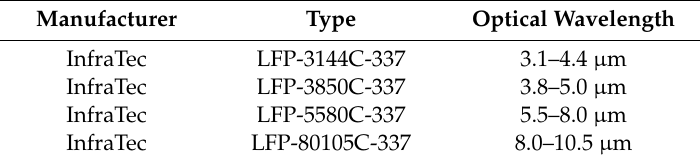
Table 1. List of sensors used in the optical electronic nose.